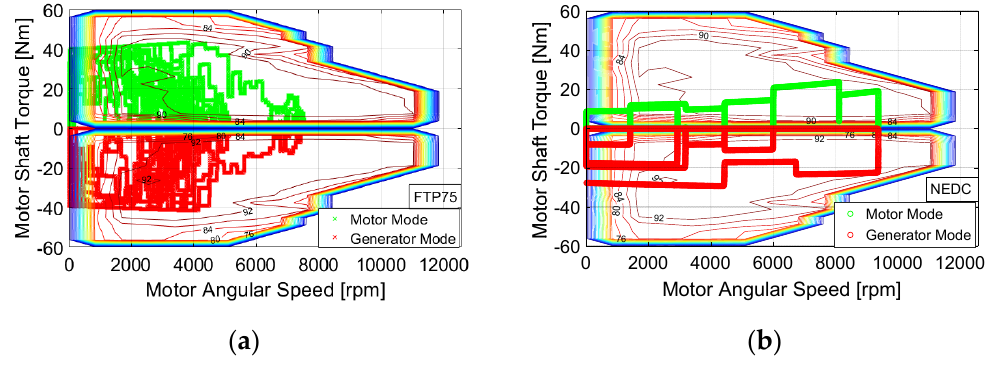
Figure 11. Downsized CVT operation points for ( a ) the FTP75 and ( b ) NEDC.